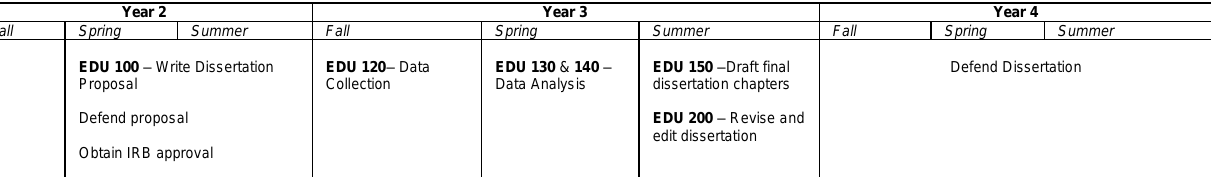
Figure 1. Embedded Dissertation Course